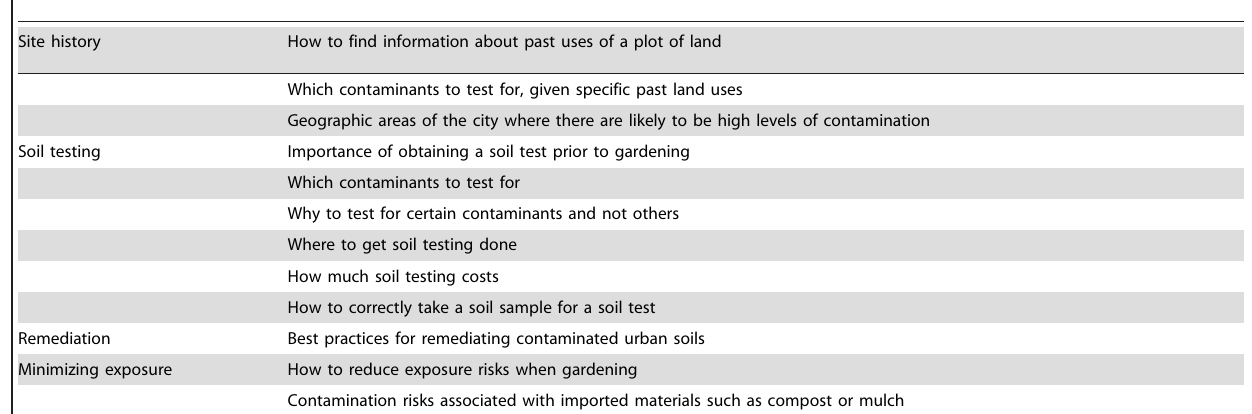
Table 6. Community gardeners’ information needs related to soil contamination, as reported by key informants.